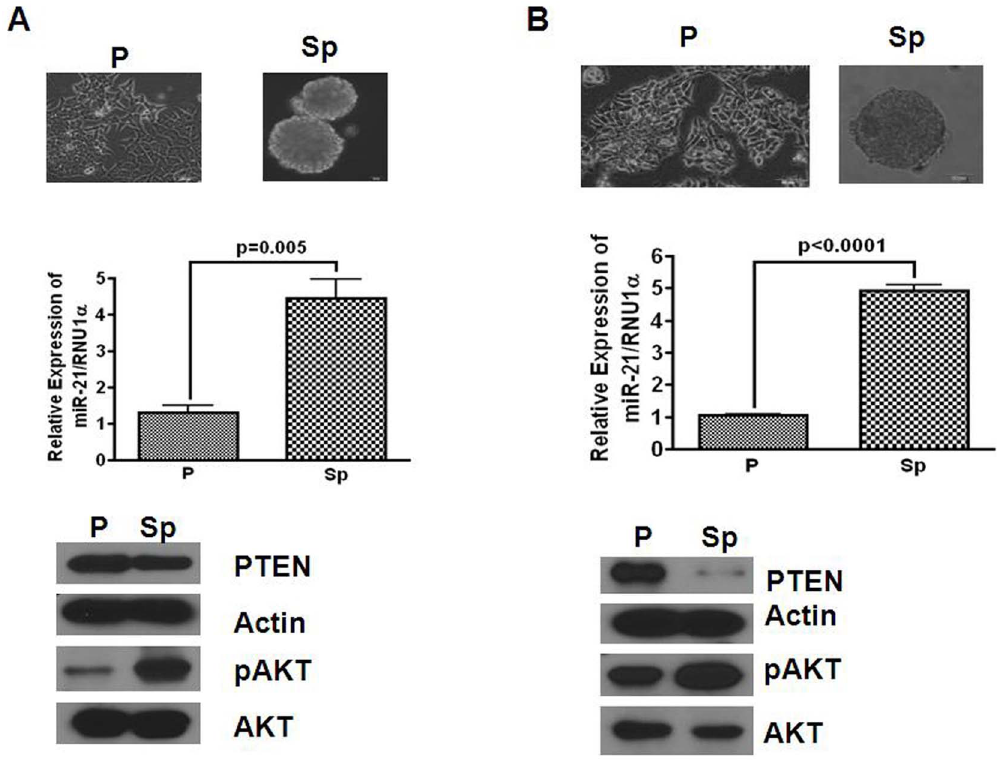
Figure 2. Photomicrograph of attached parental ( P ) and floating colonospheres ( Sp ) of HCT116 ( A ) and HT29 ( B ) colon cancer cells ( upper panel ) ; the middle panel represents the results of quantitative real time RT-PCR showing upregulation of miR-21 in colonospheres ( Sp ) when compared with the corresponding parental control ( P ) , and western blot ( lower panel ) showing the relative expression of PTEN, pAKT, total Akt in parental cell and their corresponding